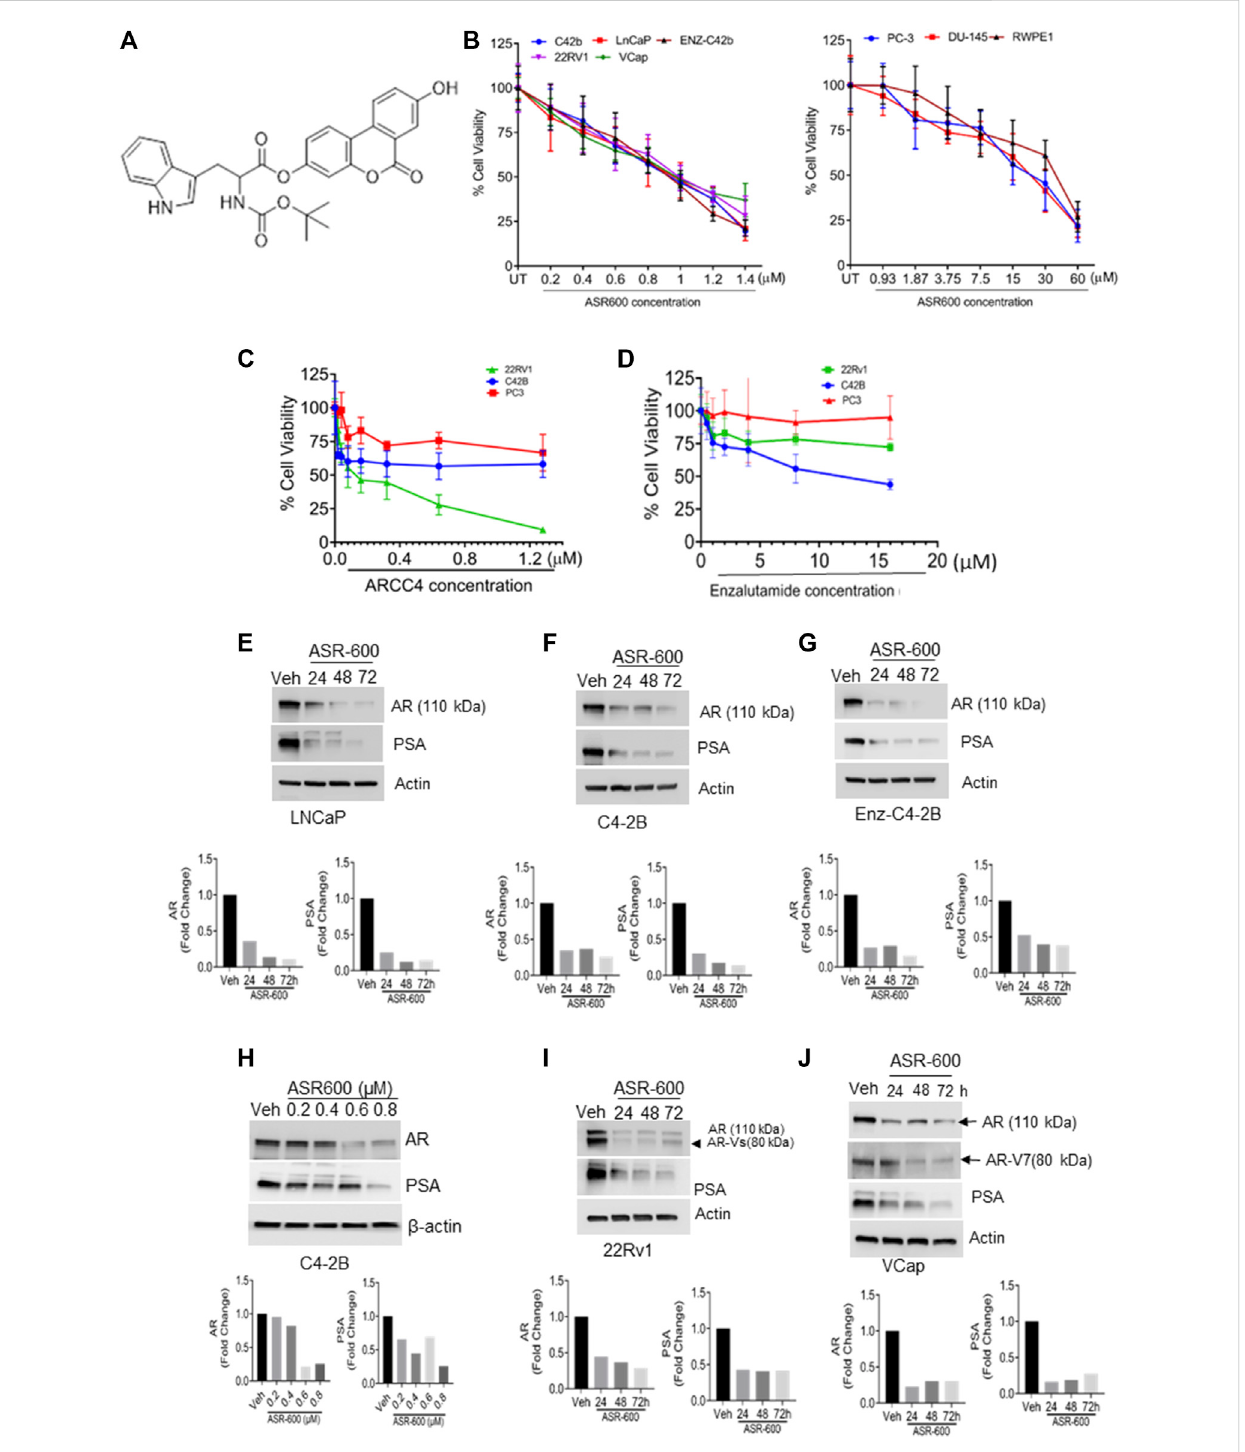
FIGURE 1 ASR-600 inhibits the AR and AR-V7 expression and abolishes the growth of AR + CaP cells. (A) . The molecular structure of ASR-600. (B) . MTT cell viability assays performed on AR + (C4-2B, LNCaP, EnZ-C4-2B, VCaP, and 22Rv1), AR- (PC-3 and DU-145) CaP, and normal prostate epithelial cell line (RWPE-1)withvehicle(DMSO)ordifferentconcentrations ofASR600. (C,D) .MTTcellviabilityassayswereperformedonAR + C4-2Band22Rv1,aswellas AR-(PC-3)cellstreatedwithvehicle(DMSO)ordifferentconcentrationsofARCC4andEnzalutamide. (E – G,I,J) immunoblotsforAR,AR-V7andPSA expressions following treated with vehicle (DMSO) or ASR-600 for 24, 48, and 72 h (H) . Immunoblots for AR and PSA expressions following treatment with vehicle (DMSO), ASR-600 (at indicated